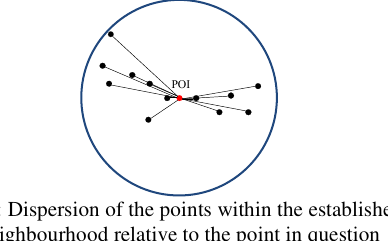
Figure 3: Dispersion of the points within the established 3D neighbourhood relative to the point in question